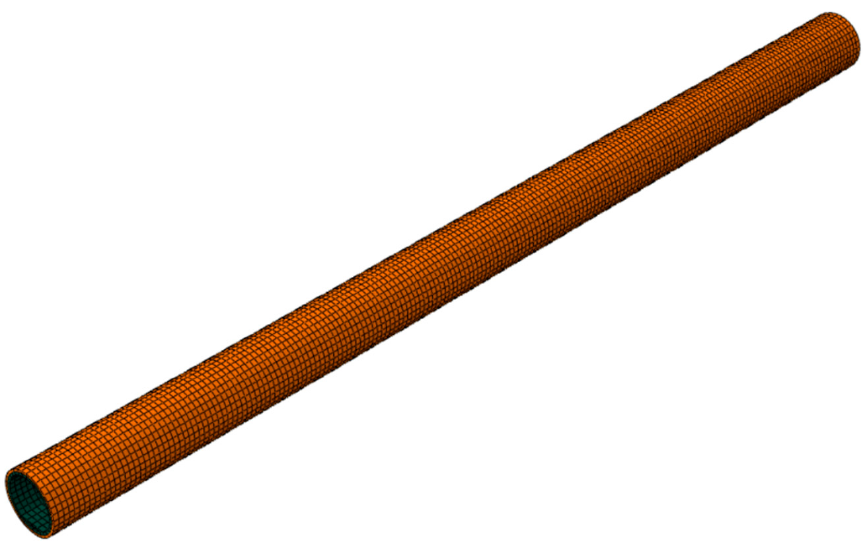
Figure 3. Schematic diagram of grid division of tunnel and grouting layer.